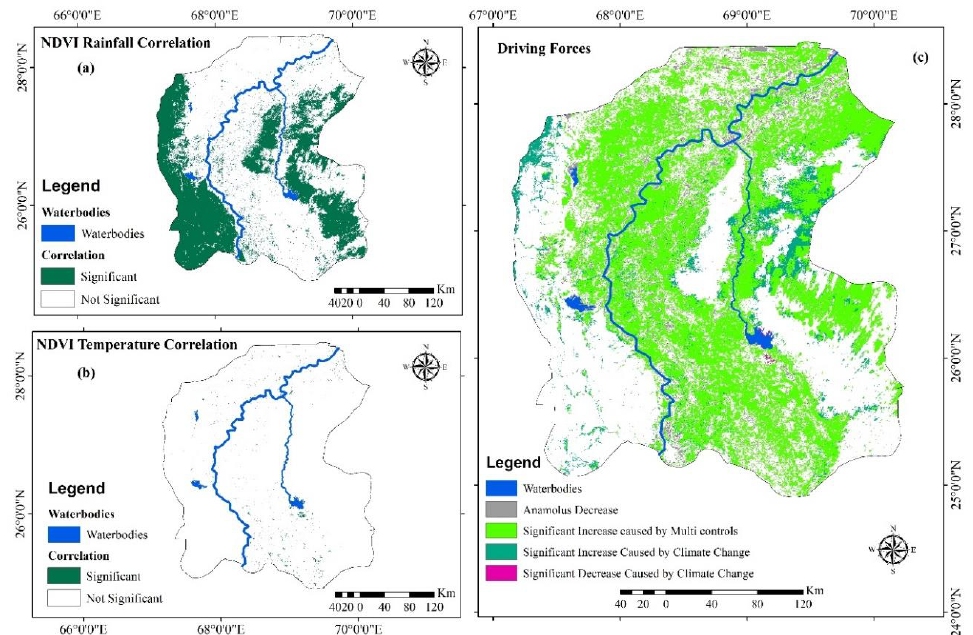
Figure 5. ( a ) Spatial pattern of Annual NDVI and rainfall correlation significance, ( b ) spatial pattern of Annual NDVI and temperature correlation significance, and ( c ) driving forces distribution of annual vegetation dynamics.